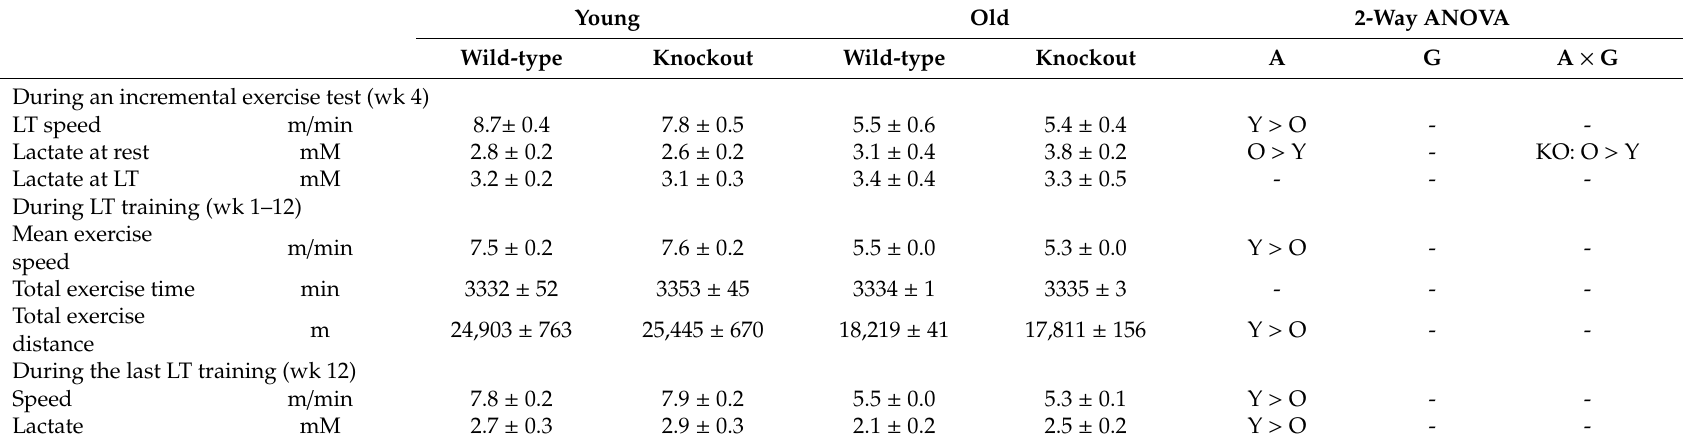
Table 1. Summary of wheel exercise training.